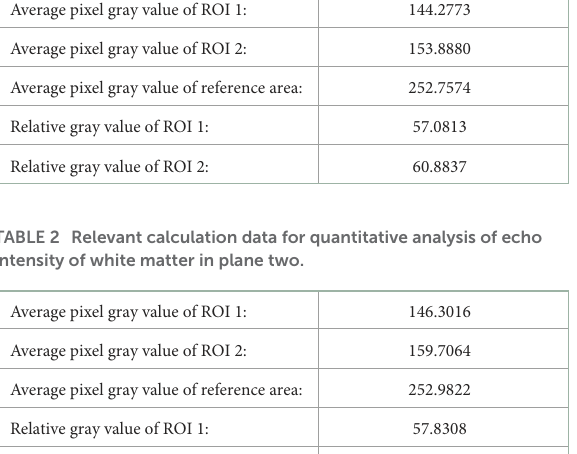
TABLE 1 Relevant calculation data for quantitative analysis of echo intensity of white matter in plane one brain. Average pixel gray value of ROI 1: